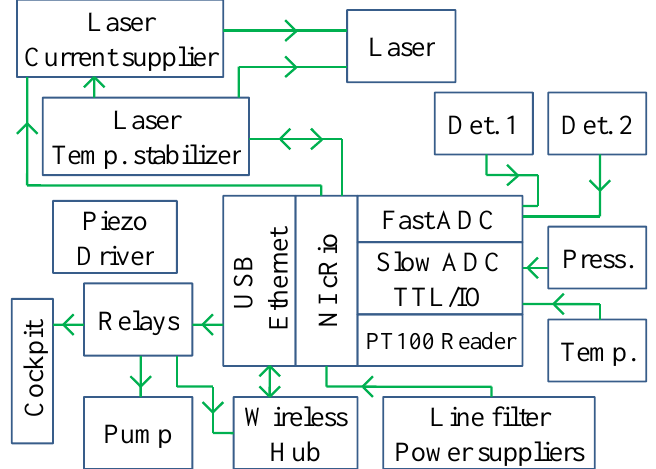
Figure 4. Block diagram of the